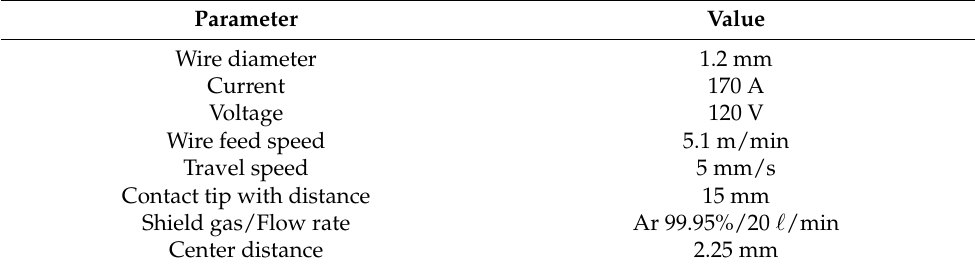
Table 1. Process parameters for testing the suggested path